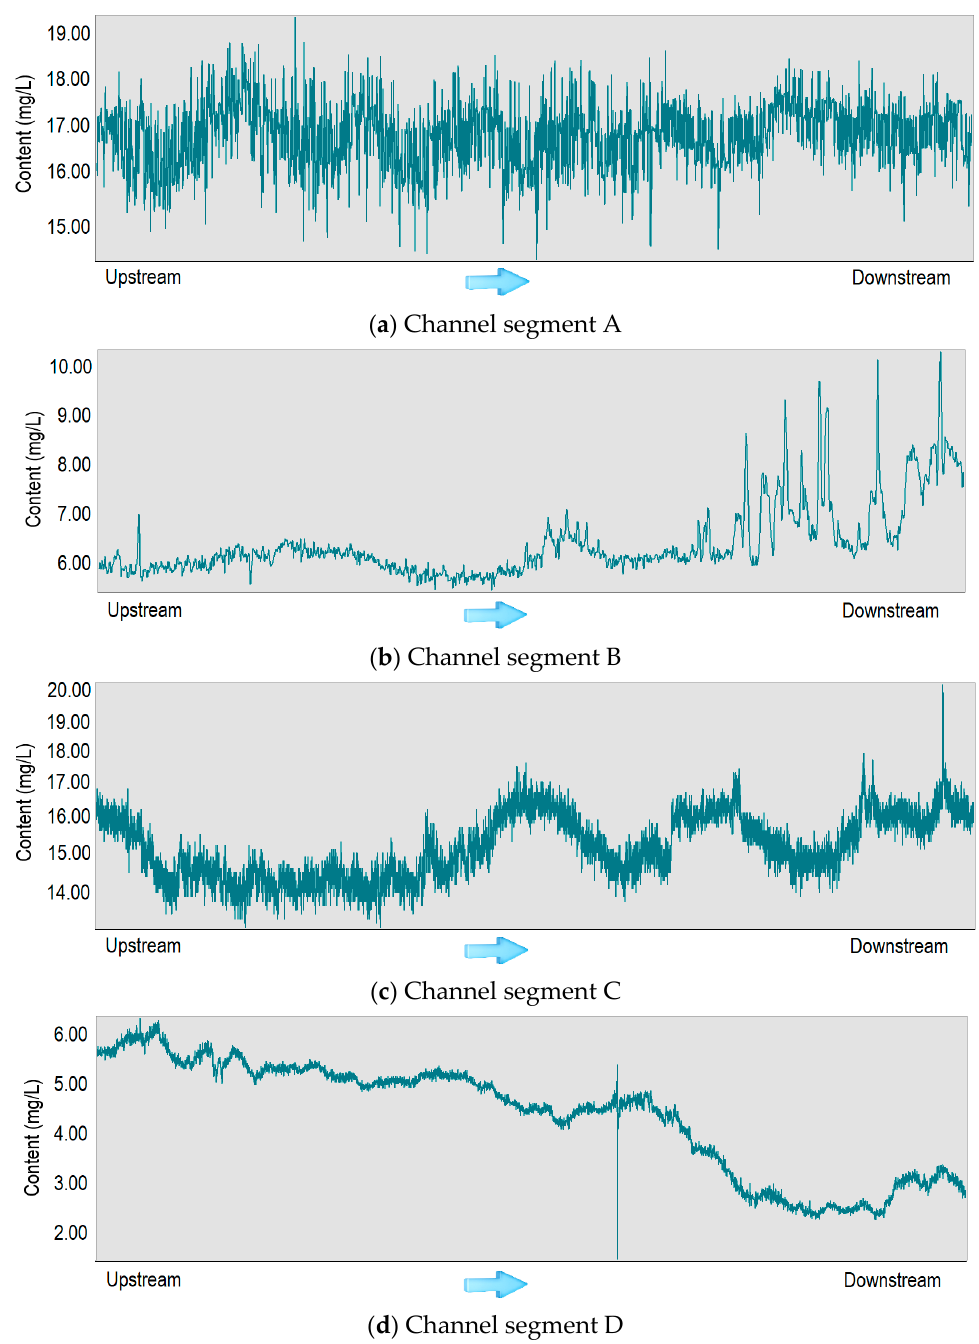
Figure 5. Relationship between COD content and flow direction in different channel segments. ( a ) The pollutant content in segment A has little to do with water flow; ( b ) The pollutant content gradually increases as the water flows downstream; ( c ) The content of pollutants shows an alternating pattern of increasing and decreasing; ( d ) Contrary to channel B, the pollutant content gradually decreases as the water fl ows downstream.